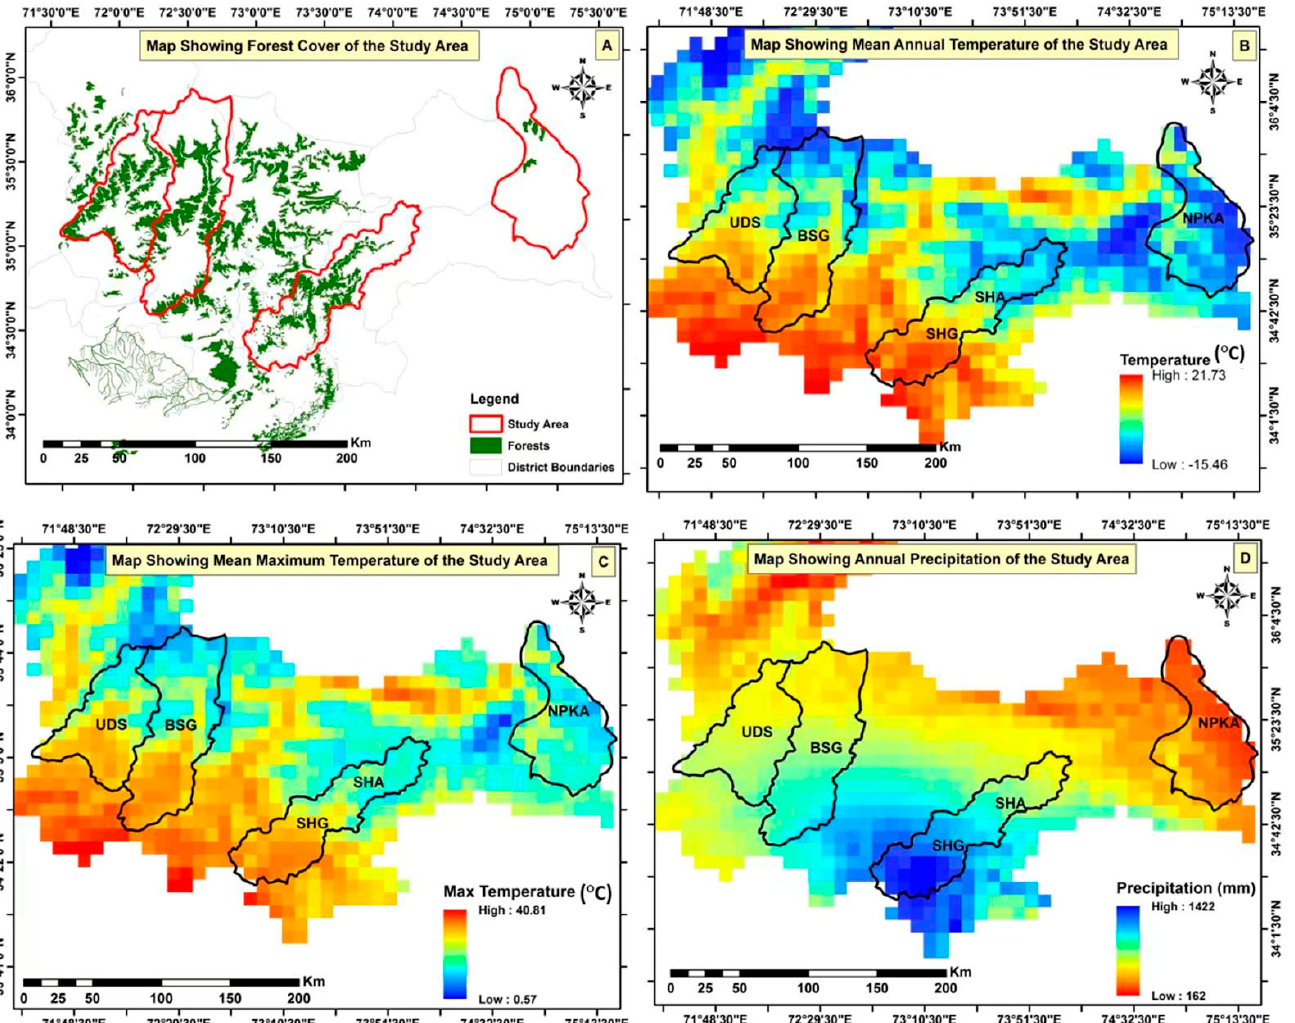
Figure 2. Map showing forest area, mean annual and maximum temperature, and precipitation of the study sites. ( A ) Map showing forest cover of the study area, ( B ) Map showing mean annual temperature of the study area, ( C ) Map showing mean maximum temperature of the study, and ( D ) map showing annual precipitation of the study area.